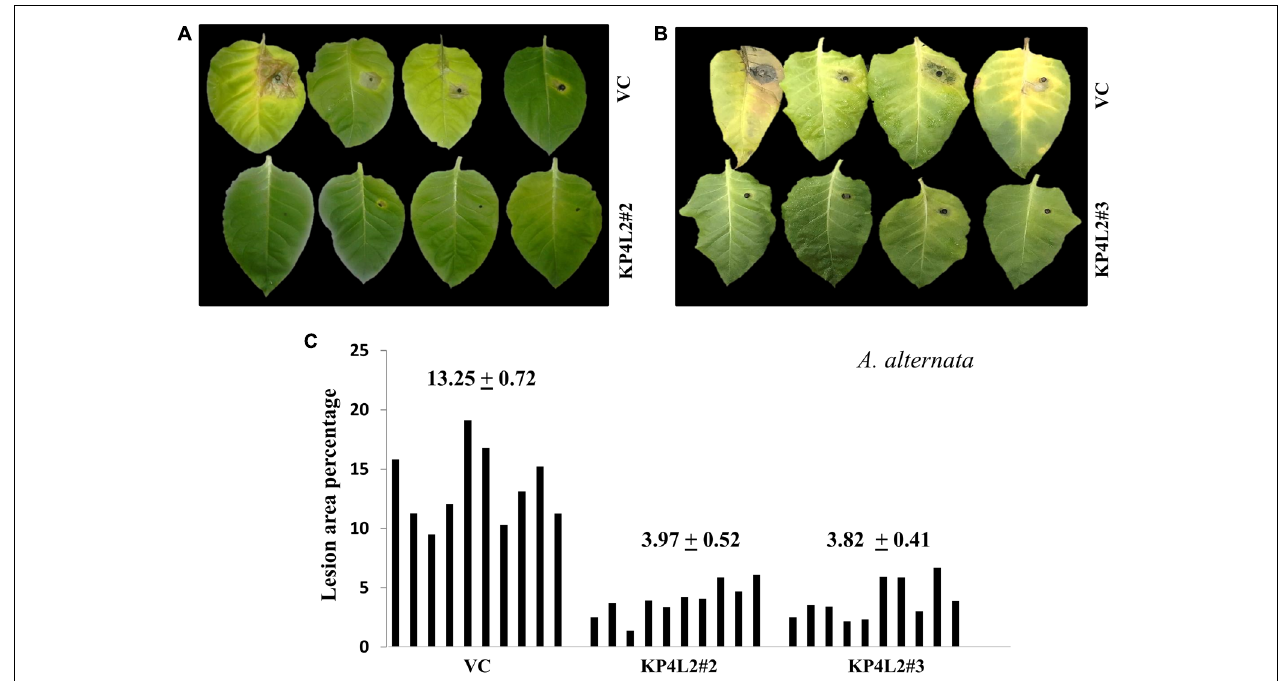
FIGURE 8 | (A,B) Alternaria alternata disease resistance assays on detached leaves of VC, KP4L2#2 and KP4L2#3. An agar plug containing the full growth of the pathogen was placed on adaxial surface of the leaves. The images indicate lesion development 2 weeks post-infection. (C) Leaves from ten plant each of KP4L2#2, KP4L2#3, and VC were infected with one agar plug and subsequently lesion area percentage was measured by millimeter graph paper method. The numbers above each set of bars indicate the mean of percent lesion area ± standard error (SE) of the